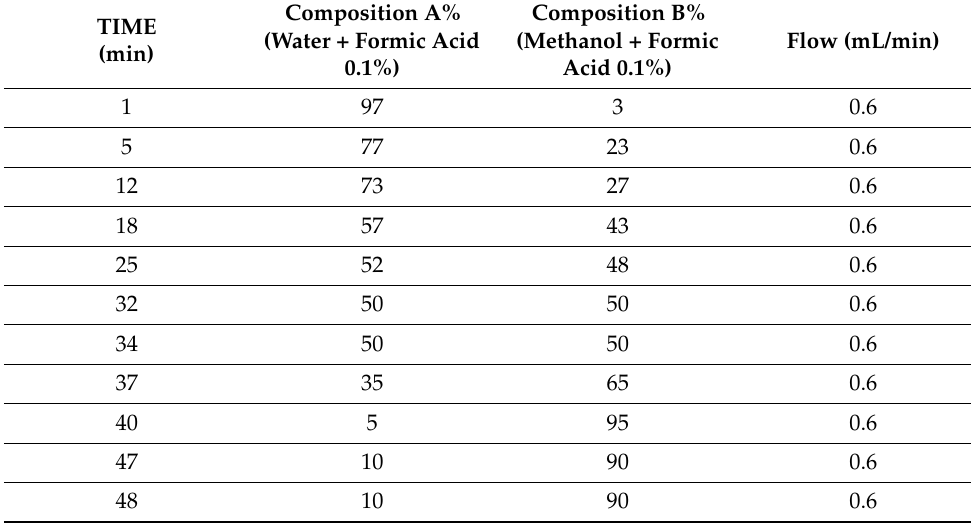
Table 2. Gradient elution conditions.